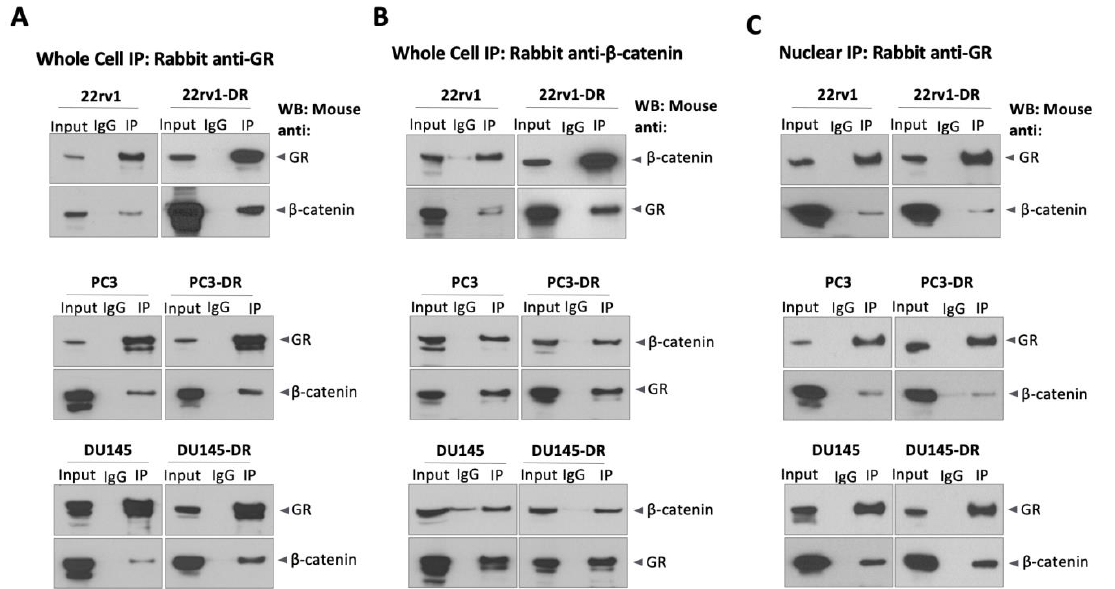
Figure 7. GR and β-catenin interact in prostate cancer cells. Co-immunoprecipitation studies were performed in soluble protein lysates from DTX-sensitive and DTX-resistant 22rv1, PC3, and DU145 ( B ) were used for protein immunoprecipitation, and both proteins were detected by immunoblotting using specific mouse monoclonal antibodies. Co-immunoprecipitation of GR and β -catenin was ( C ). Prior to immunoprecipitation, cells were cultured in medium supplemented with CS-FBS for nuclear protein complexes. Immunoprecipitation of nuclear proteins was also performed using rabbit antibodies specific for GR and β -catenin, followed by immunoblotting detection of both proteins using specific mouse monoclonal antibodies. Normal rabbit IgG was used as a negative control for immunoprecipitation, and whole cell lysates collected concomitantly with immunoprecipitation reactions were used as inputs (10% of IP). Immunoprecipitations were performed at least 3 times independently, and representative blots are